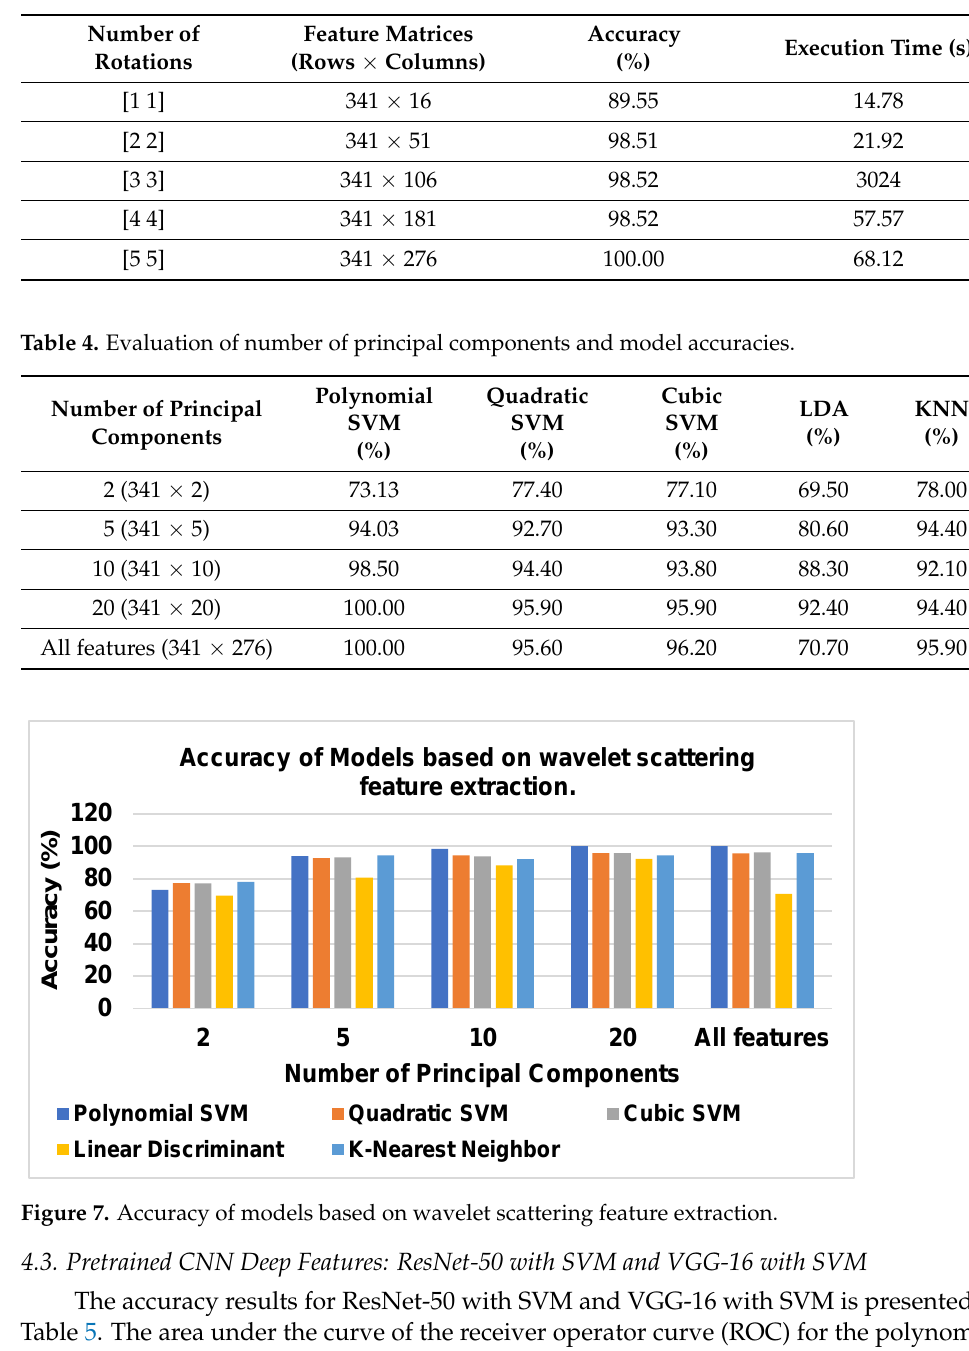
Table 5. Accuracy results of ResNet-50 with SVM and VGG-16 with SVM.